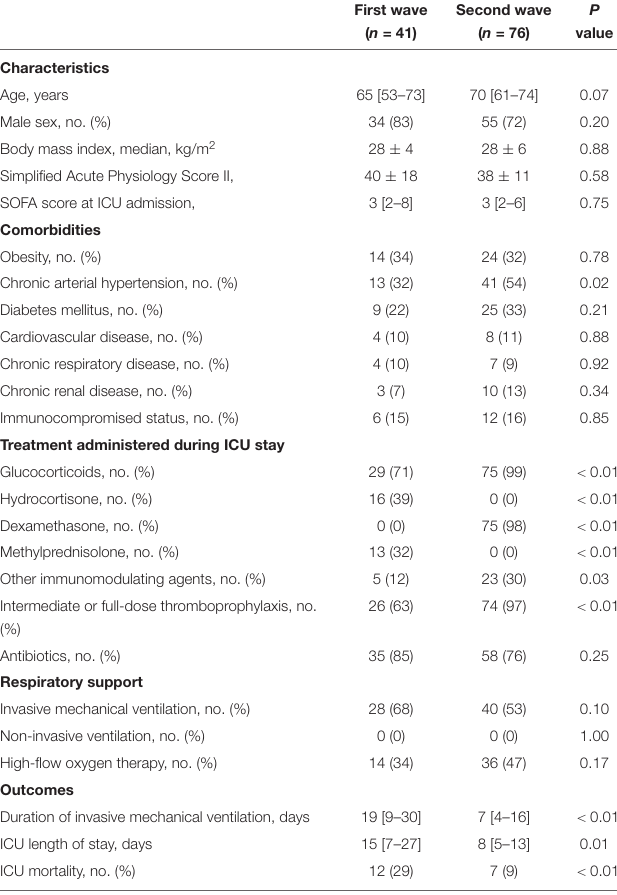
TABLE 1 | Patient characteristics and outcomes in the two pandemic waves of